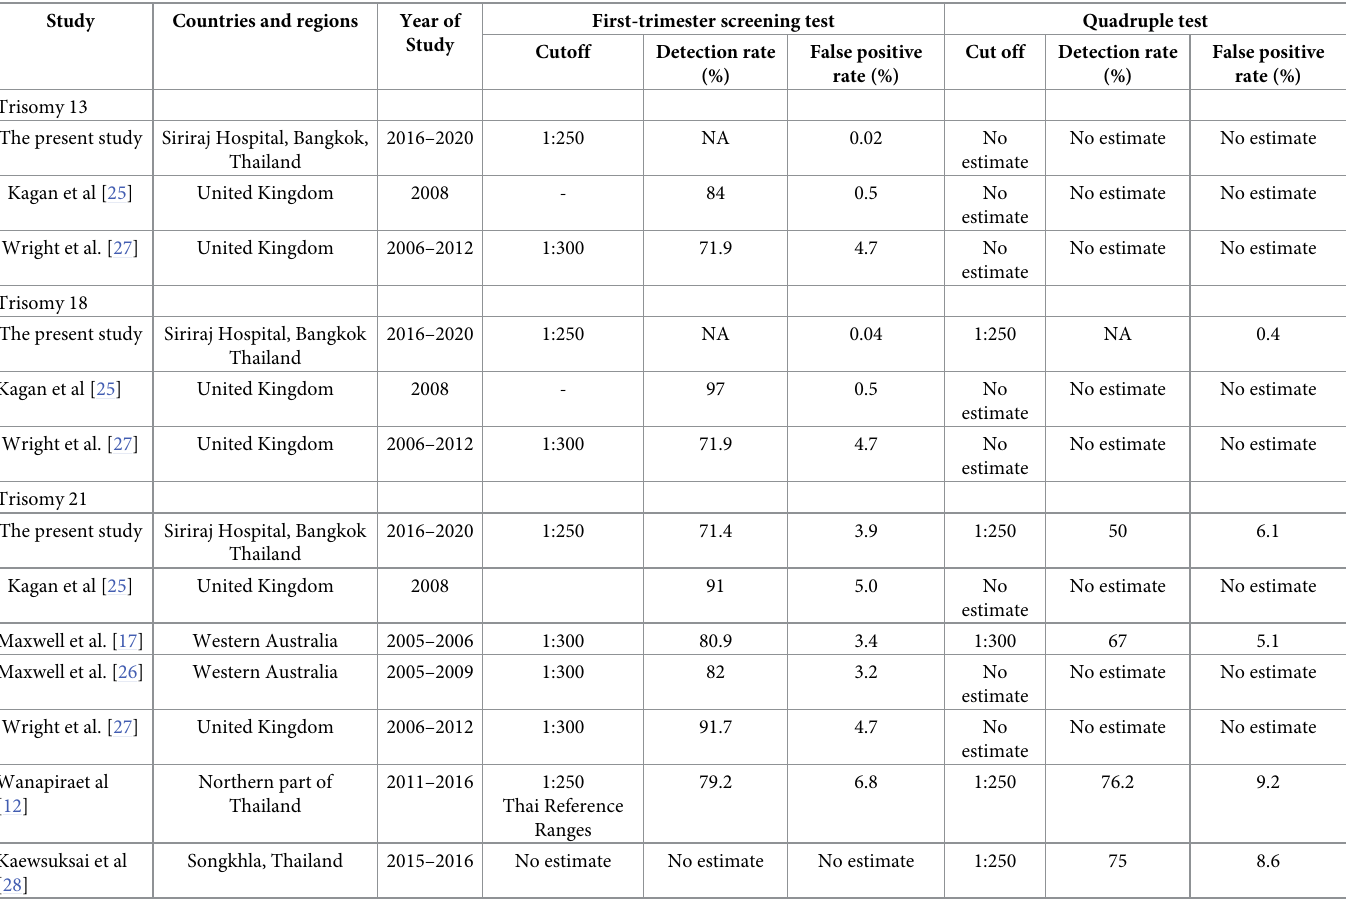
Table 3. Detection rate and false positive rate of serum screening tests from other